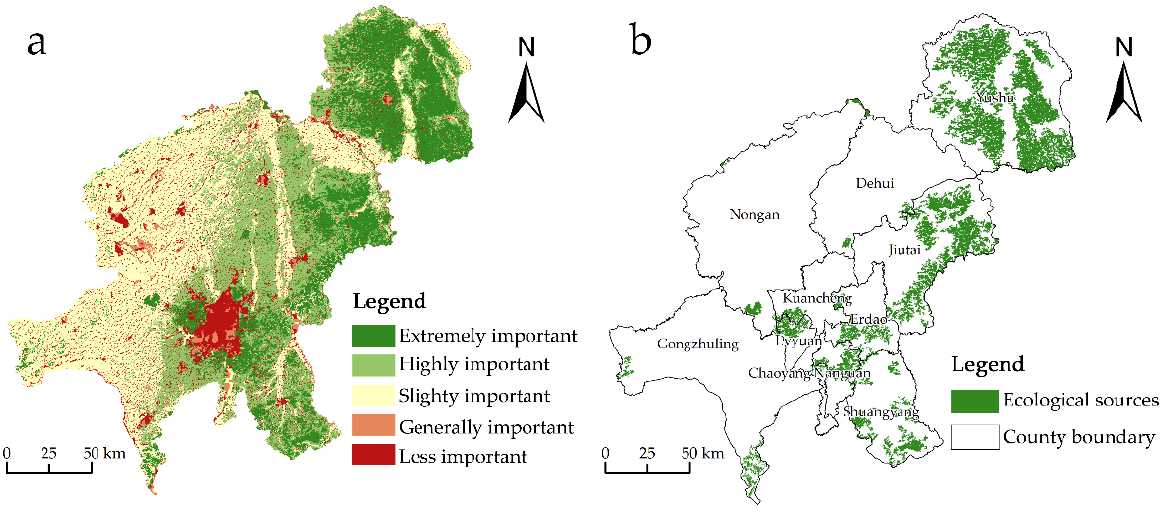
Figure 3. Ecosystem service importance and ecological sources screening. ( a ) Ecosystem service im- portance rating. ( b ) Ecosystem sources.